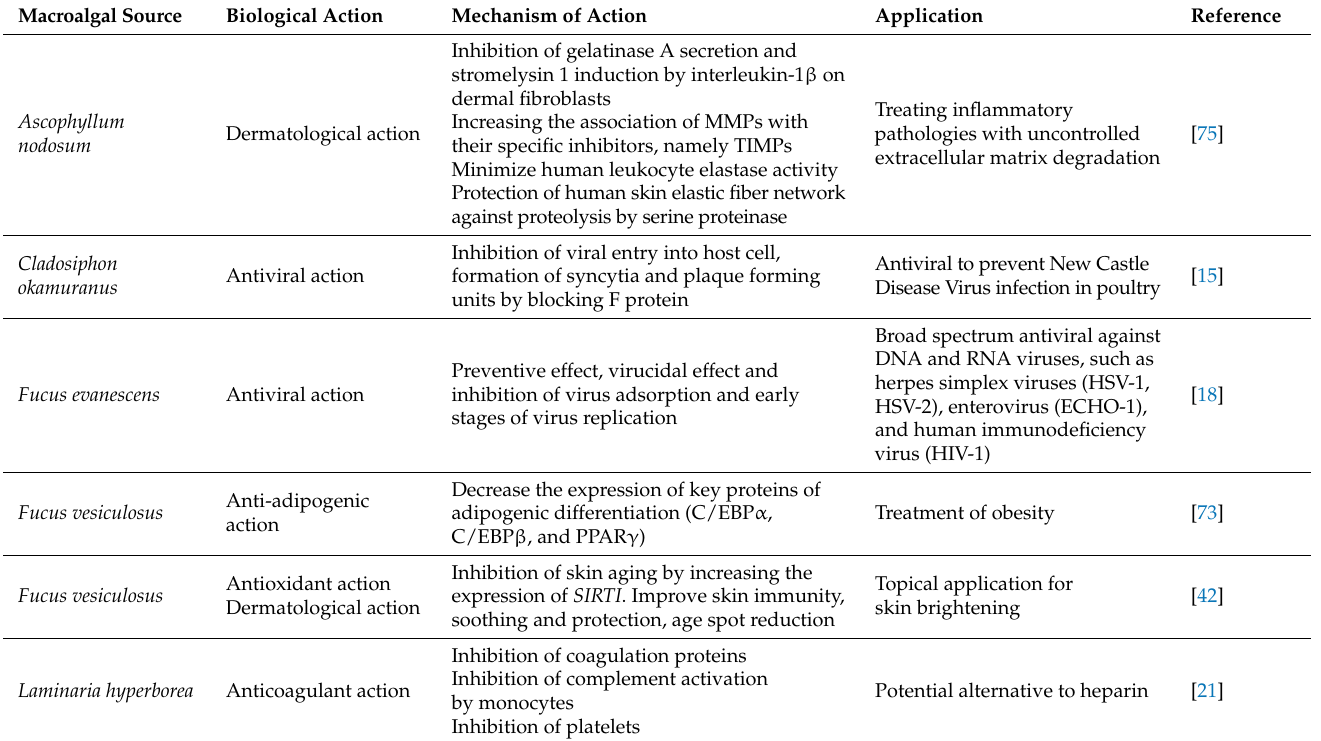
Table 3. Biological actions and applications of fucoidans from brown